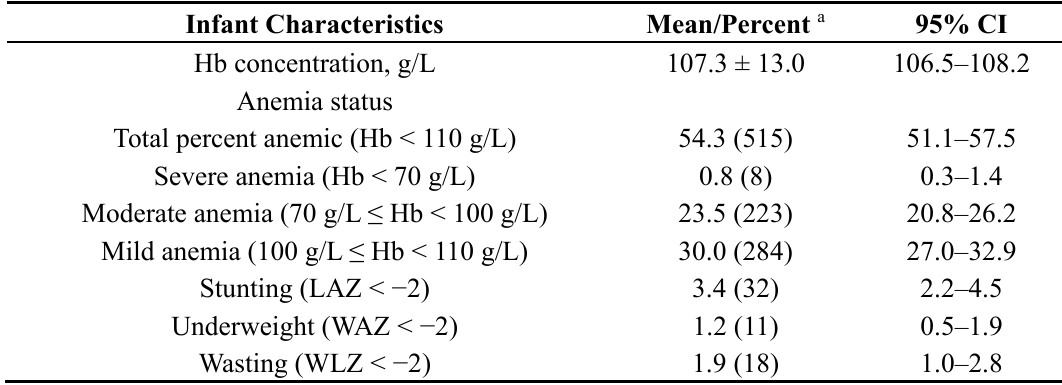
Table 2. Hemoglobin concentration, anemia prevalence, and physical development of sample infants in rural Shaanxi Province ( N =